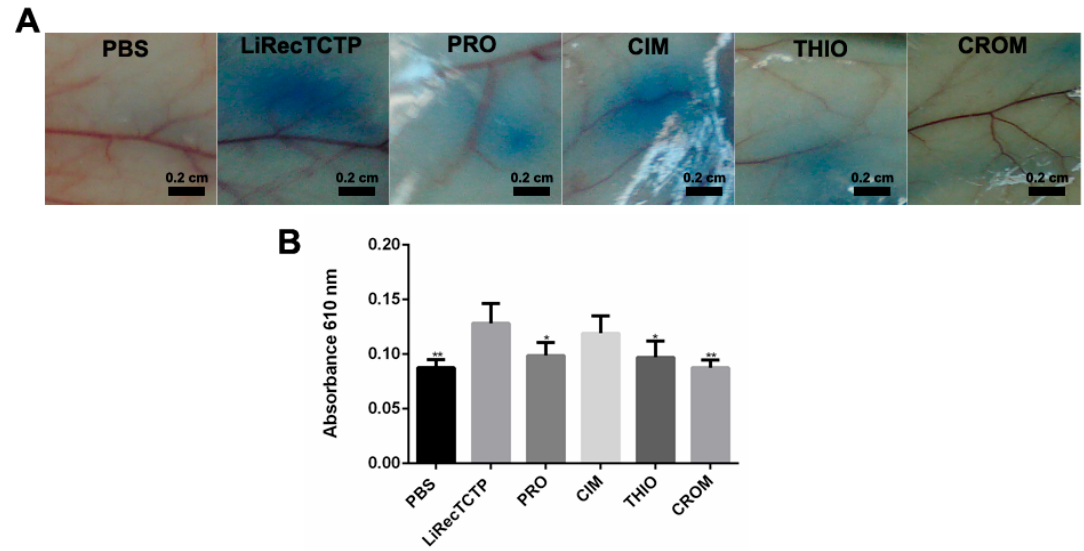
Figure 4. E ff ect of treatment with the mast cell degranulation inhibitor or histamine receptor antagonists on vascular permeability induced by LiRecTCTP. Mice ( n = 5) were pre-treated with promethazine (PRO), cimetidine (CIM), thioperamide (THIO), cromolyn (CROM), or PBS (control). Animals received solution of Evans blue dye in PBS intravenously prior to intradermal injection of LiRecTCTP (10 µ g) or PBS (control). ( A ) Representative images of mice dorsal skin at the point of sample inoculation. ( B ) Quantitative measurement of dye leakage induced by LiRecTCTP and inhibition with CROM, PRO, CIM, and THIO. Data represent mean ± s.e.m of one representative experiment from three independent biological replicates (* p < 0.1 and ** p <